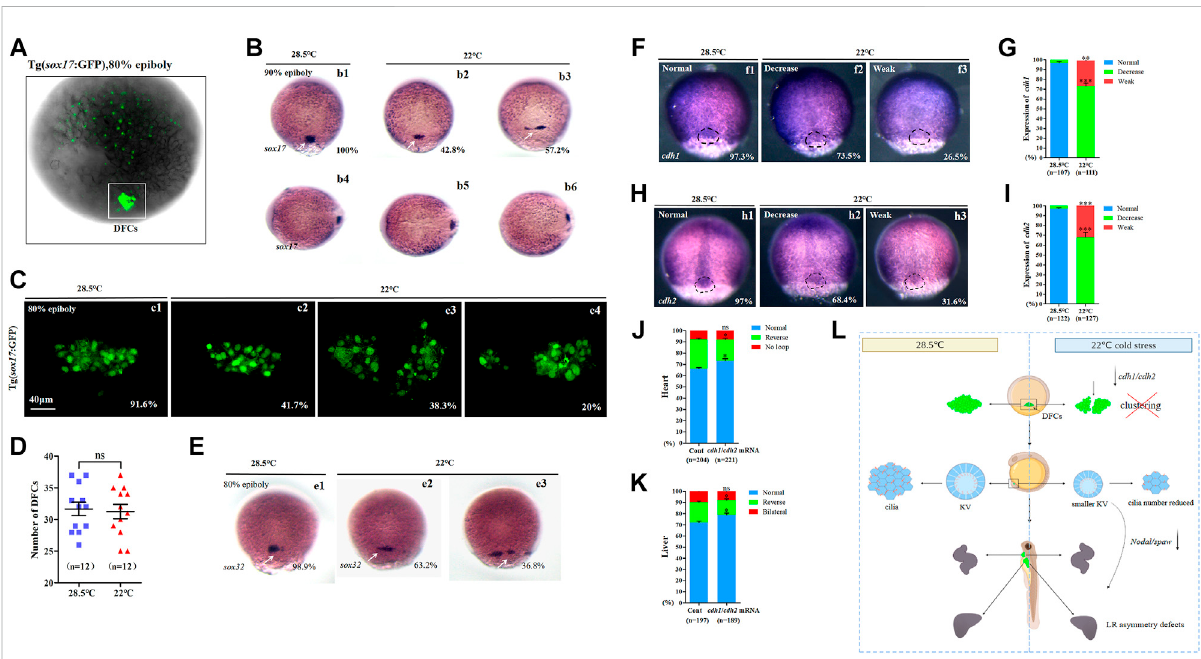
FIGURE 4 Expression of sox17, sox32, cdh1, and cdh2. (A) GFP is expressed in endodermal cells and DFCs at 80% epiboly in Tg (sox17:GFP) transgenic line (DFCs are circled with a white square). (B) Expression of sox17 was examined using WISH at 80% epiboly. b1, normal sox17 at 28.5 ° C (100%, n = 67); b2, normal sox17 at 22 ° C (42.8%, n = 74, p < 0.002); b3 dispersed expression of sox17 at 22 ° C (57.2%, n = 74, p < 0.001). DFCs (white arrow). (C) NumberDFCsandmigrationsituationofDFCs.C1,DFCswithnormalmigrationat28.5 ° C(91.6%, n =12);c2,DFCswithnormalmigrationat22 ° C (41.7%, n =12, p < 0.003);c3,dispersedDFCsat22 ° C(38.3%, n =12, p < 0.002);c4:dispersedDFCsat22 ° C(20%, n =12, p < 0.004).Scalebar,40 μ m. (D) StatisticalanalysisofDFCnumber. n =12;ns,notsigni fi cant (E) Expressionofsox32 at80%epiboly.e1,normalsox17 at28.5 ° C(98.9%,n=64);e2, normal sox17 at 22 ° C (63.2%, n = 70, p < 0.01); e3, dispersed expression of sox17 at 22 ° C (36.8%, n = 70, p < 0.03). DFCs (white arrow). (F) Expression ofcdh1at80%epiboly.f1,normalcdh1at28.5 ° C(97.3%, n =107);f2,decreasedexpressionofcdh1intheDFC fi eldat22 ° C(73.5%, n =111, p < 0.001); f3,weakexpressionofcdh1intheDFC fi eldat22 ° C(26.5%, n =111, p < 0.01).DFC fi eld(whitecircle). (G) Percentagesofnormal,decreased,andweak expression ofcdh1 inembryostreatedat28.5 ° Cor22 ° C.A statistically signi fi cantdifference( p < 0.01) couldbeseen between theembryos treatedat 28.5 vs 22 ° C. (H) Expression of cdh2 in 80% epiboly. h1, normal cdh2 at 28.5 ° C (97%, n = 122); h2, decreased expression of cdh1 in the DFC fi eld at 22 ° C (68.4%, n = 127, p < 0.001); h3, weak expression of cdh1 in the DFC fi eld at 22 ° C (31.6%, n = 127, p < 0.003). DFC fi eld (white circle). (I) Percentagesofnormal,decreased,andweak expressionofcdh2inembryostreatedat28.5 ° Cor22 ° C.Astatisticallysigni fi cantdifference ( p < 0.003) could be seen between the embryos treated at 28.5 vs 22 ° C. (J) Percentage of normal looping, reversed looping, and no looping of the heart in embryos treated at 22 ° C (as control) and embryos treated at 22 ° C plus overexpression of cdh1/cdh2 mRNA in DFCs. A statistically signi fi cant difference ( p < 0.05) could be seen between control embryos and embryos injected with cdh1/cdh2 mRNA. (K) Percentage of normal liver, reversed liver, and liver bi fi da in embryos treated at 22 ° C and embryos treated at 22 ° C plus overexpression of cdh1/cdh2 mRNA in DFCs. A statistically signi fi cantdifference( p < 0.05)couldbeseenbetweenthem. (L) Mechanismdiagram.Ns,notsigni fi cant; “ * “ p < 0.05; “ ** “ p < 0.03;and “ *** “ p <